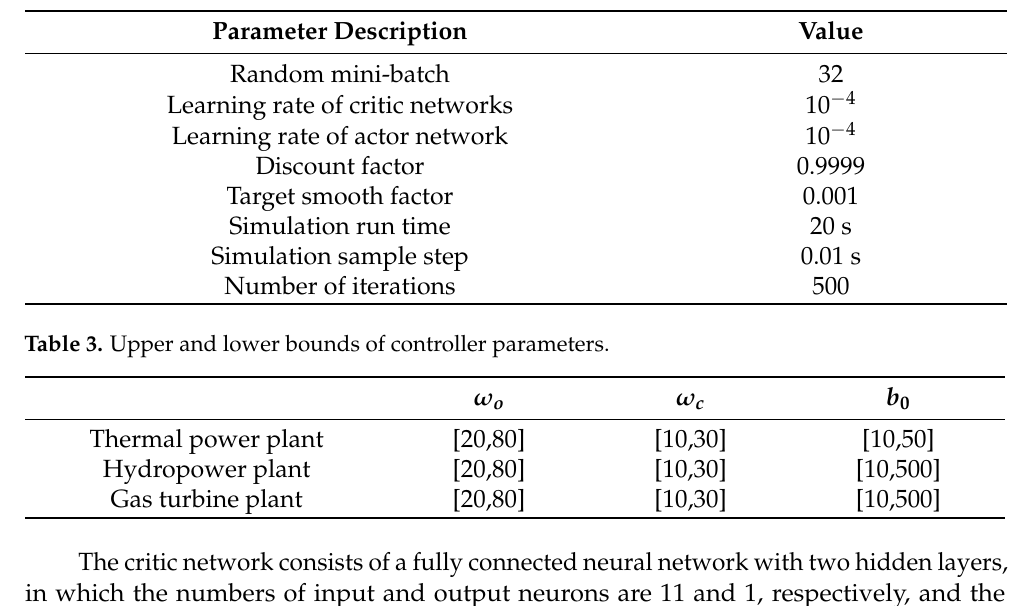
Table 2. Parameter settings during SAC training.